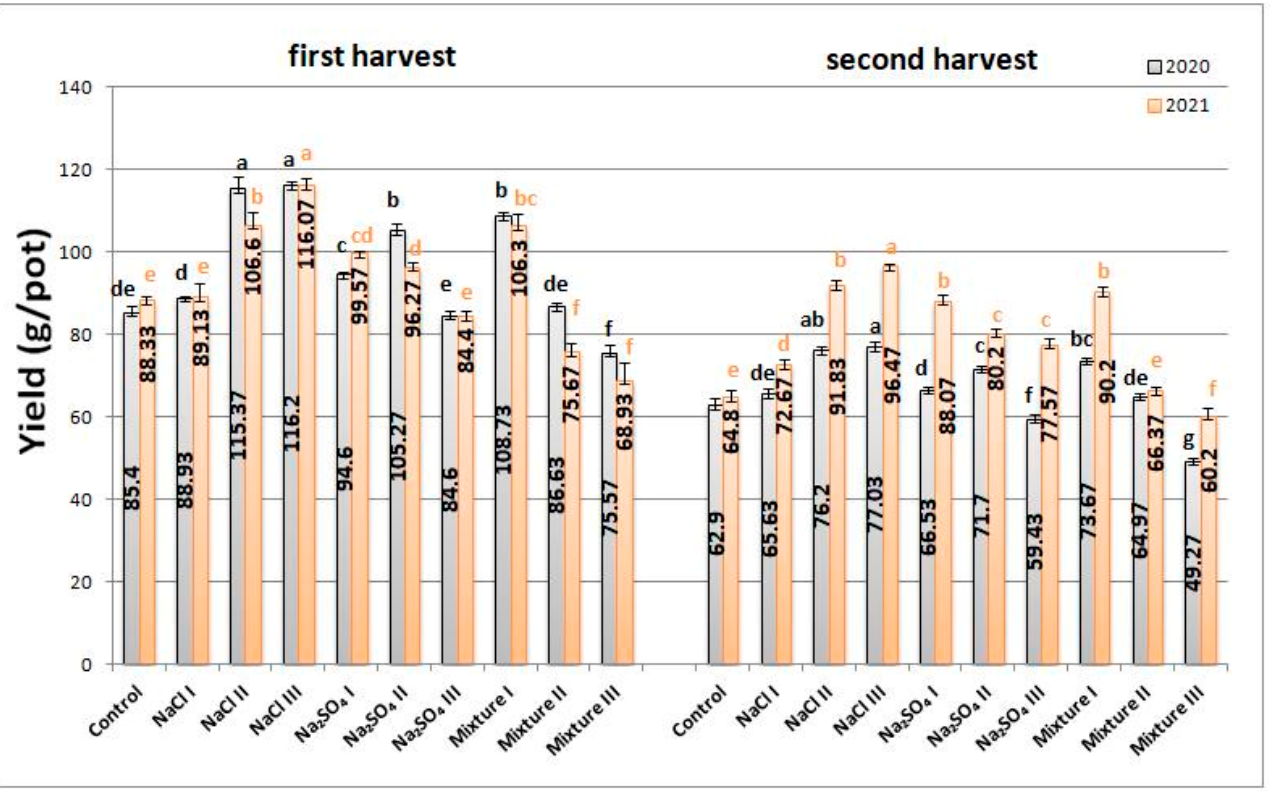
Figure 1. Average yield per vegetation pot for Nepeta racemosa Lam. for both analyzed years with significant differences at 0.05 level indicated with letters.